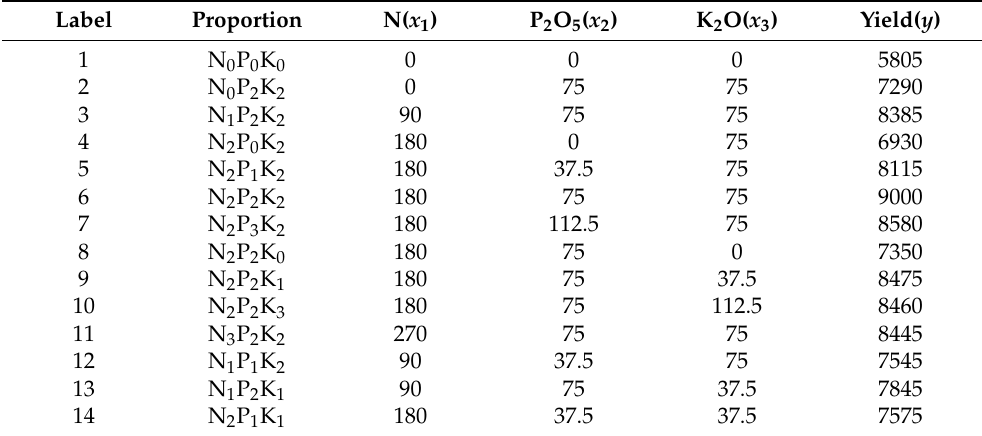
Table 3. Dataset obtained from the test field (Kg/hm 2 ).